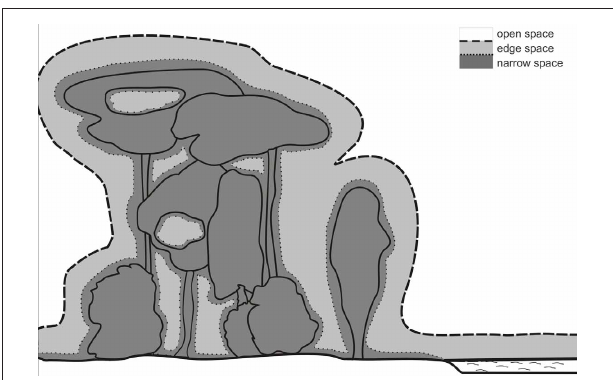
FIGURE 4 | Foraging habitats of bats. The borders between open and edge space is determined by the echolocation behavior of the bats. Bats react to background targets in edge space but not in open space. The border is species specific. The narrow space begins with the clutter overlap zone which depends on signal duration.